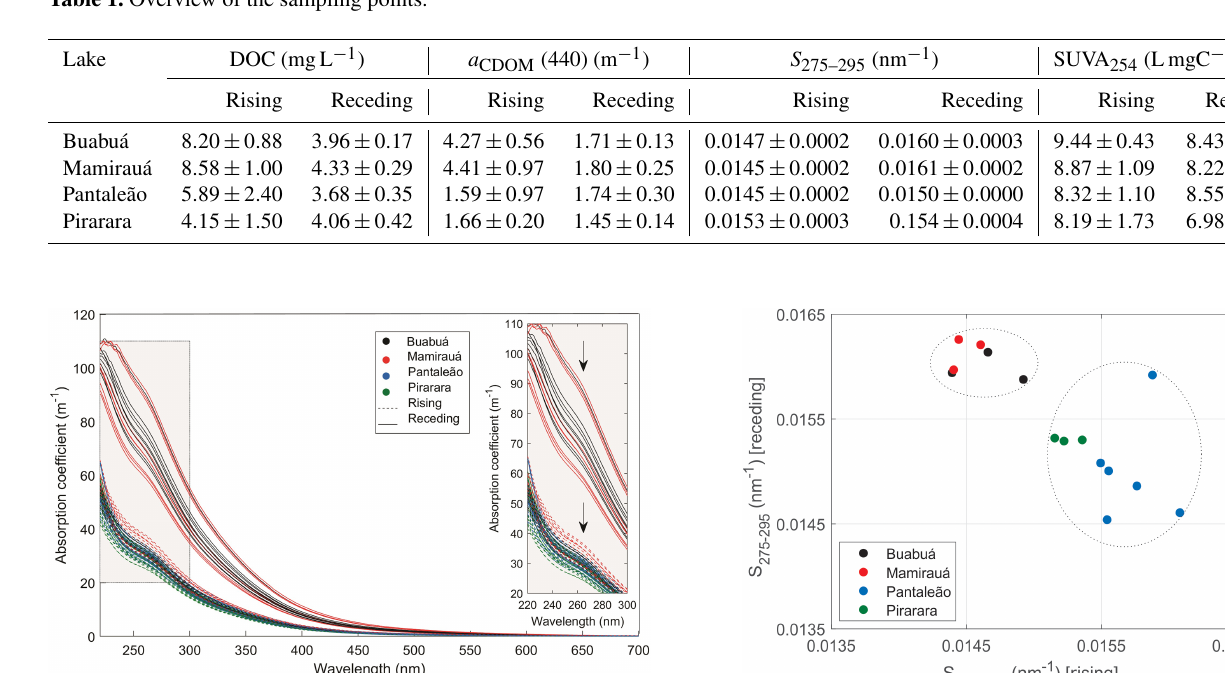
Table 1. Overview of the sampling points.